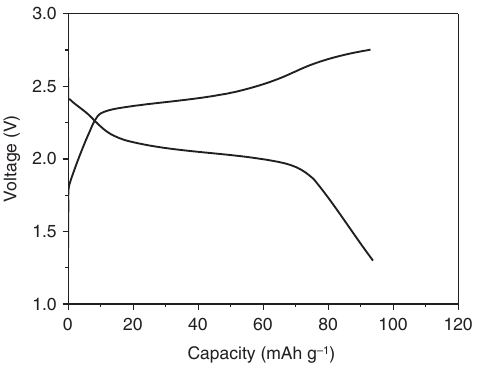
Figure 6 | Electrochemical performance with microporous carbon/iodine cathode. The discharge/charge curve of Mg/I 2 battery with MPC/I 2 cathode at